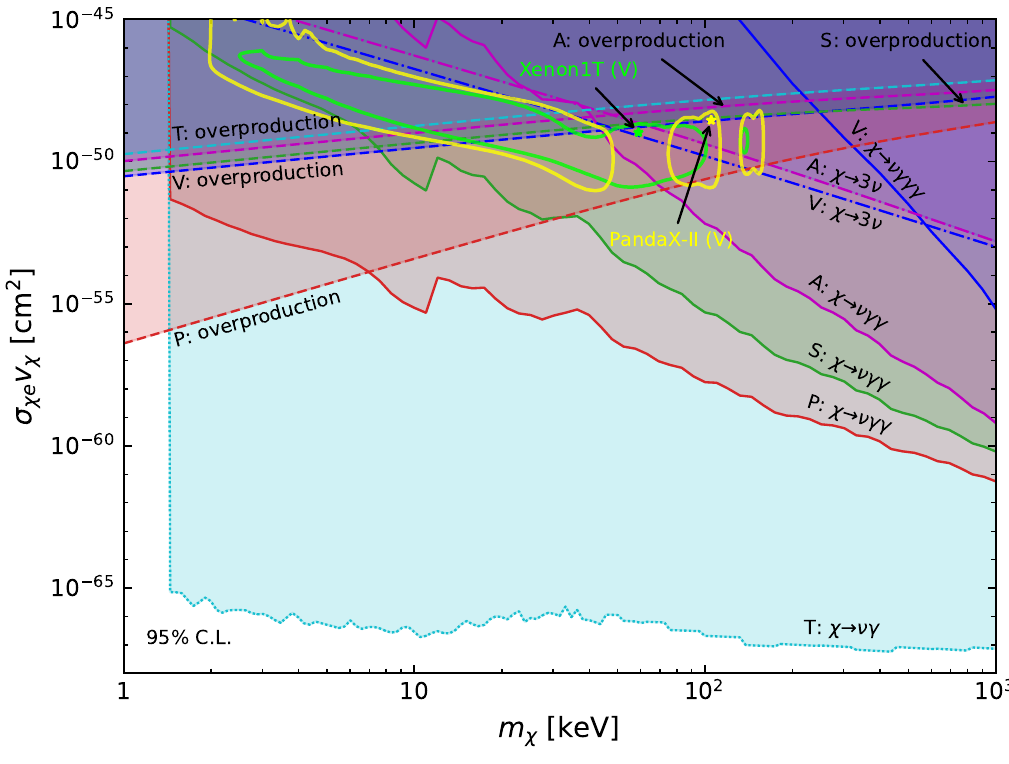
Figure 4 . The 95% C.L. constraints on the fermionic absorption operators from the DM overpro- duction (filled regions with dashed boundary), the cosmological evolution history (filled regions for invisible decay χ → 3 ν with dot-dashed boundary), as well as the astrophysical X(gamma)-ray data (filled regions for visible decays χ → νγ ( s ) ). The exclusion regions are filled with colors for scalar (S: green), pseduo-scalar (P: red), vector (V: blue), axial-vector (A: magenta), and tensor (T: cyan) operators, respectively. Note that the exclusion region for the tensor operator from astrophysical X(gamma)-ray constraint (T: χ → νγ ) uses dotted boundary to indicate that this constraint is subject to uncertainty in the regularization scheme. For comparison, the best-fit points (star) and 95% C.L. contours (contour) for the Xenon1T (light green) and PandaX-II (yellow) are also shown with the vector-type operator as an